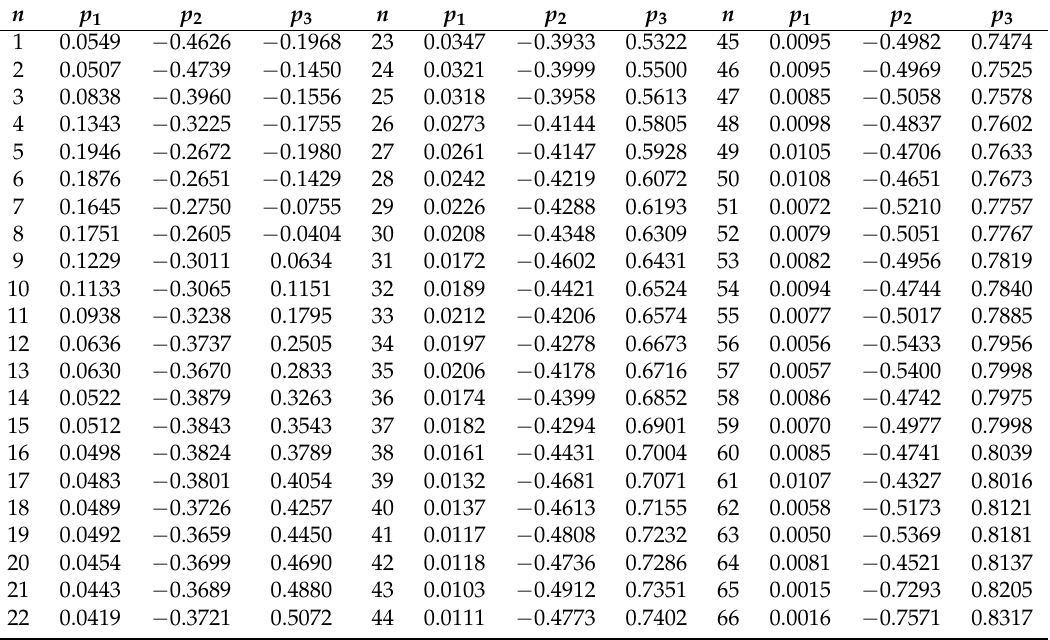
Table C2. The coefficients for the fitting function of µ against P f , ILS : f µ ( x ) = p 1 x p 2 + p 3 . The tolerable = 0.001. failure rate is P tol f